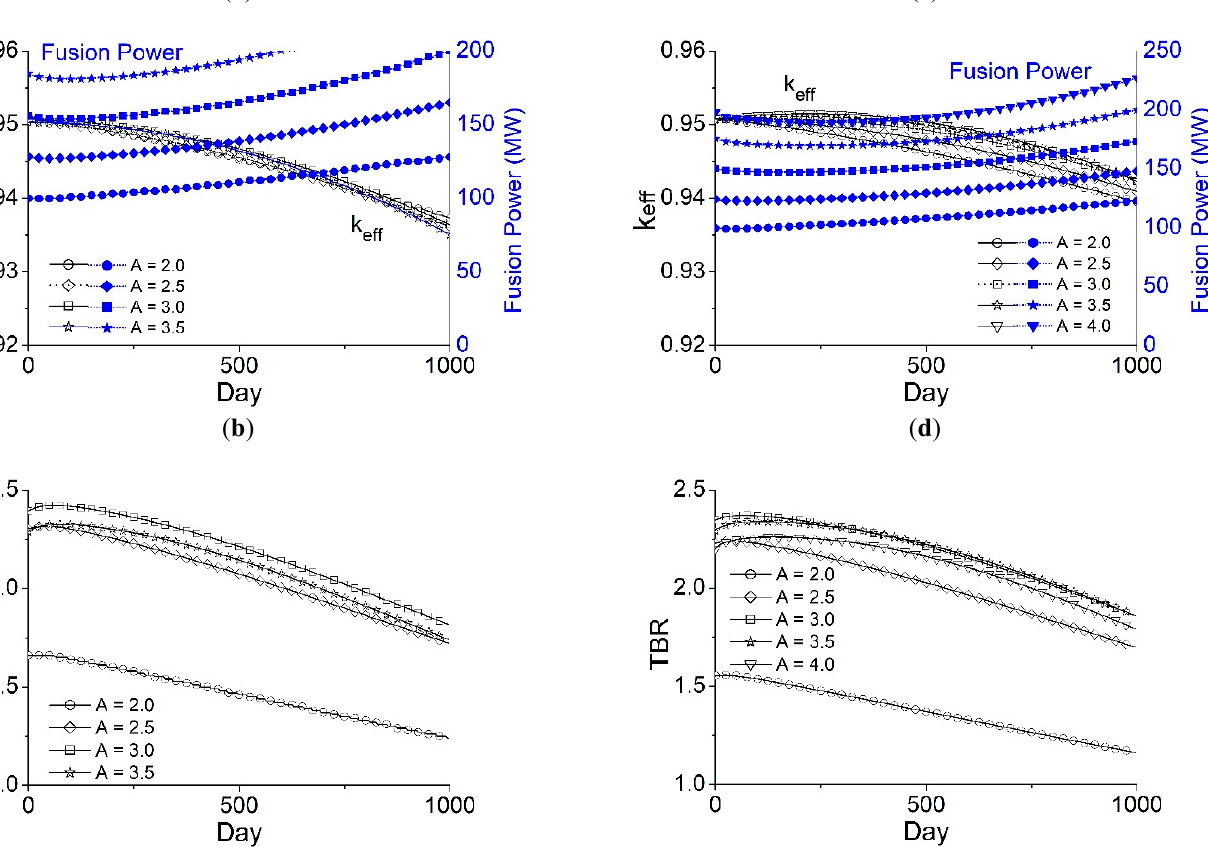
Figure 5. Variation of ( a , c ) k eff and necessary fusion power, and ( b , d ) TBR as the TRU burned up with FLiBe. ( a , b ) P f,m = 200 MW; ( c , d ) P f,m = 300 MW.